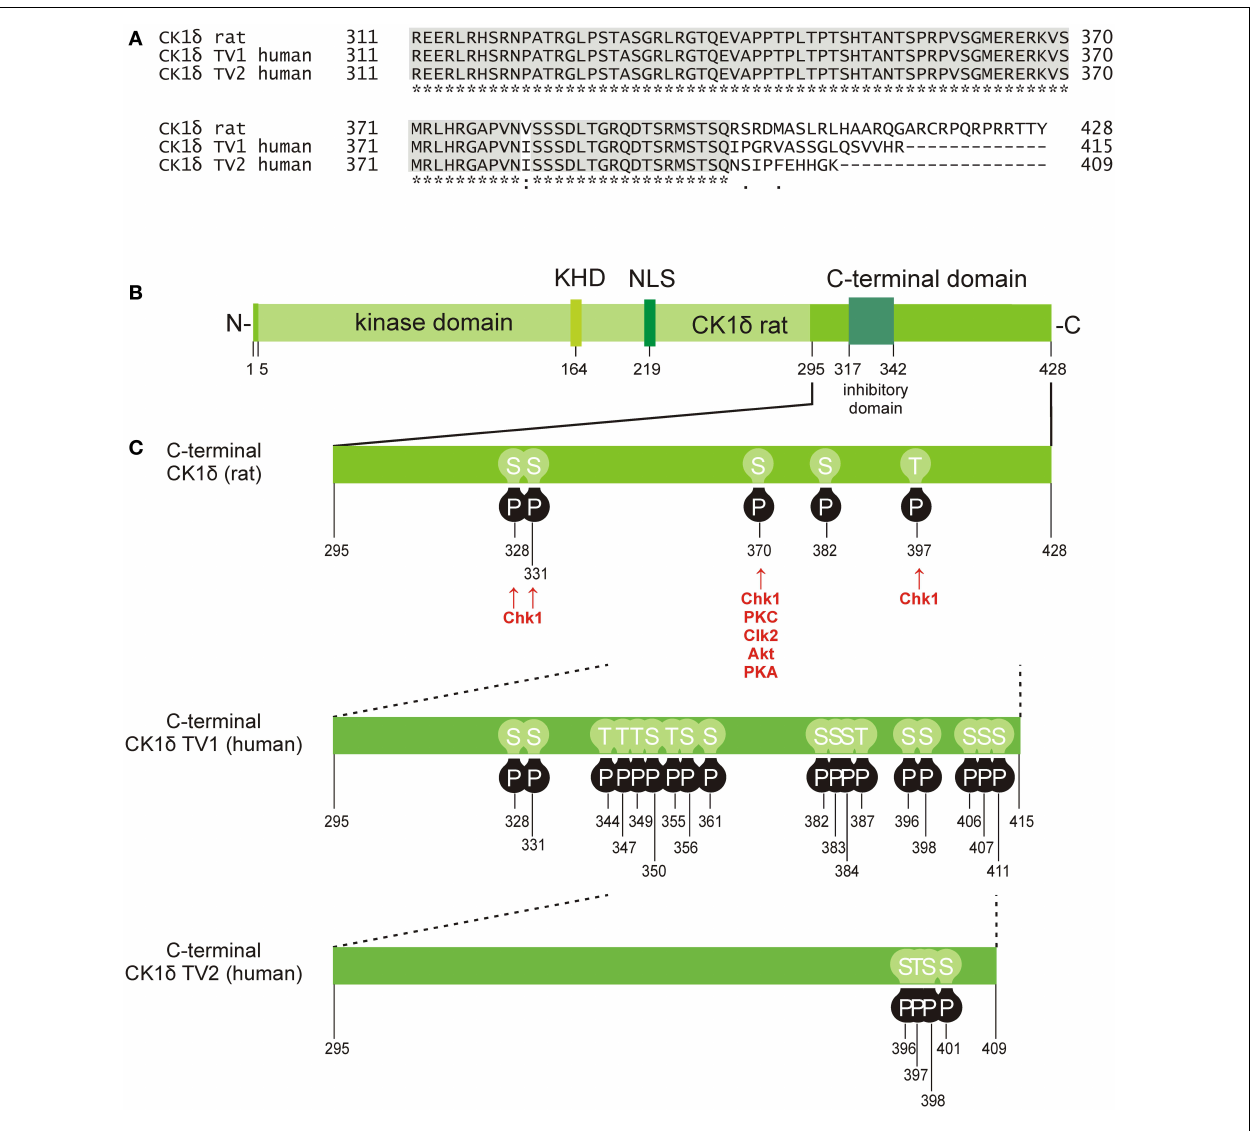
FIGURE 2 | Phosphorylation sites located in the C-terminal domain of CK1 δ . (A) Alignment of the rat CK1 δ C-terminal sequence with the human CK1 δ transcription variants 1 and 2 C-terminal sequences (accession numbers L07578, NM001893, and NM139062, respectively) generated by using the program ClustalW (36, 37), showing conserved amino acids (gray) and obvious differences in the C-terminal domain beyond amino acid